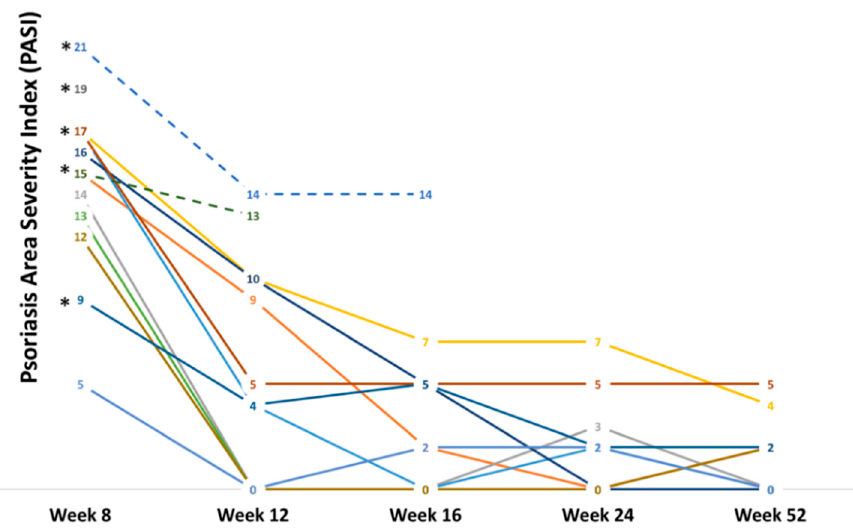
Figure 2. PASI trends in erythrodermic patients from week eight to week 52. * Patients that displayed more than one type of drug use (tobacco, cannabis, alcohol).